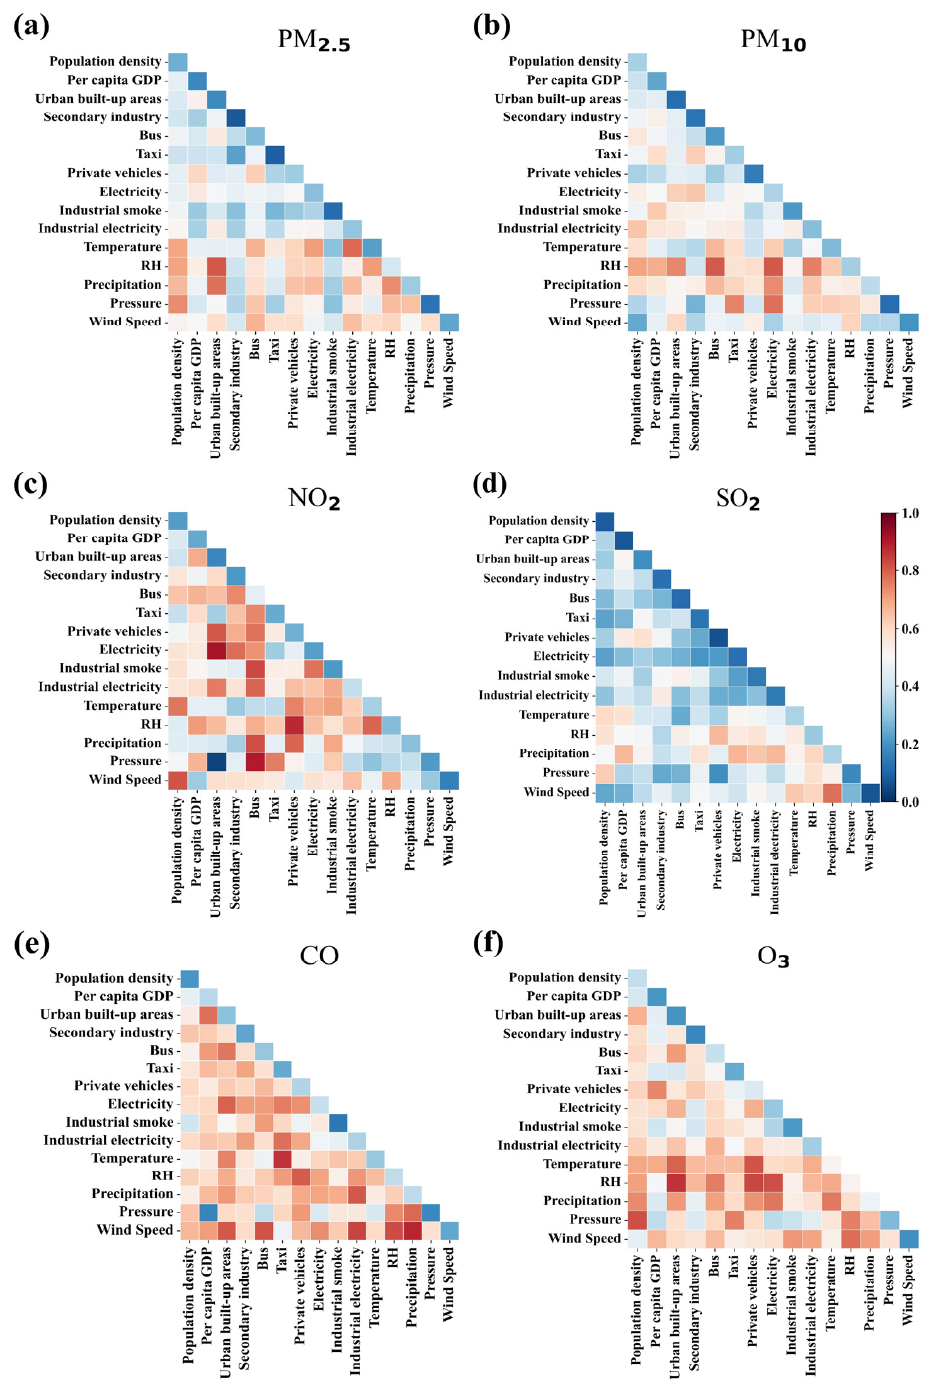
Figure 7. Impact of the interaction between natural and socio-economic factors on changes in PM 2.5 , PM 10 , NO 2 , SO 2 , CO and O 3 during the lockdown: ( a ) PM 2.5 , ( b ) PM 10 , ( c ) NO 2 , ( d ) SO 2 , ( e ) CO, ( f ) O 3.